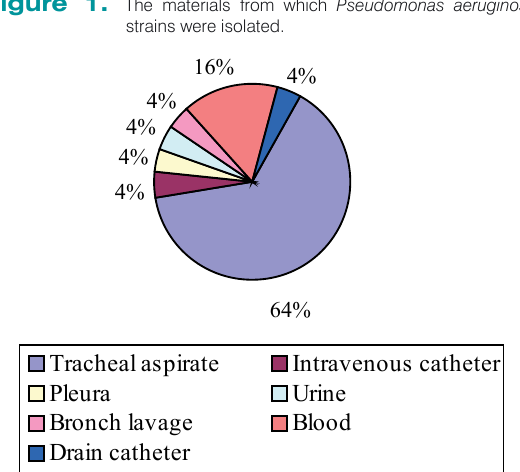
Figure 1. The materials from which Pseudomonas aeruginosa strains were